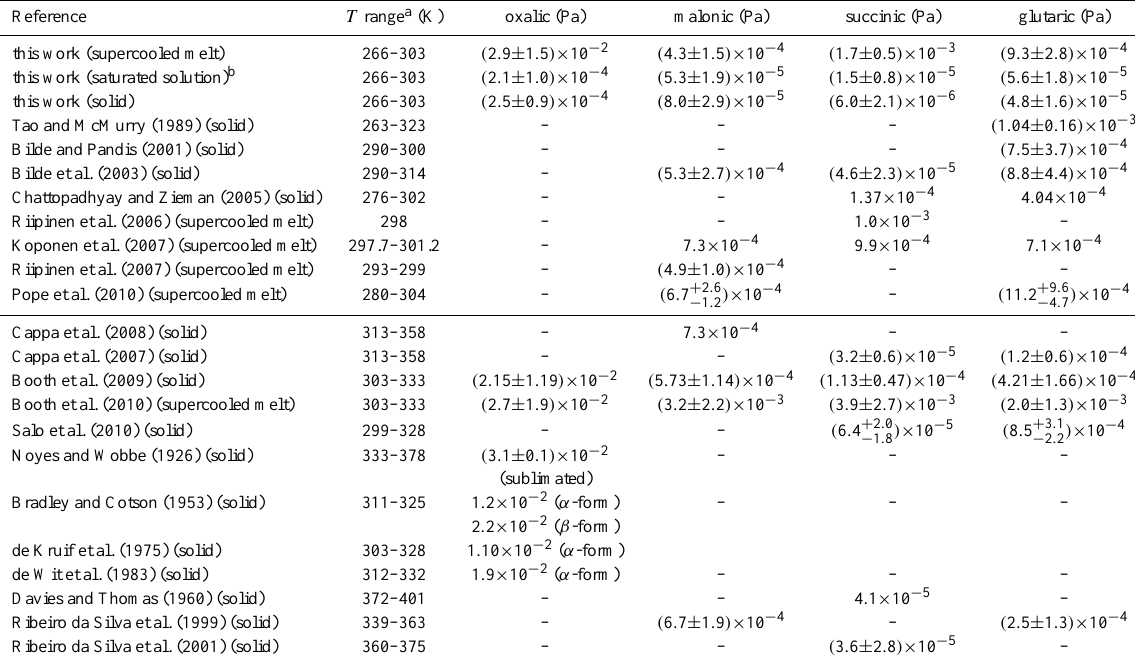
Table 3. Comparison of room temperature data ( T = 298 . 15K) of vapor pressures for the short chain dicarboxylic acids. The upper half of the table shows data originally obtained at room temperature or below, the lower half data measured at higher temperatures and extrapolated to room